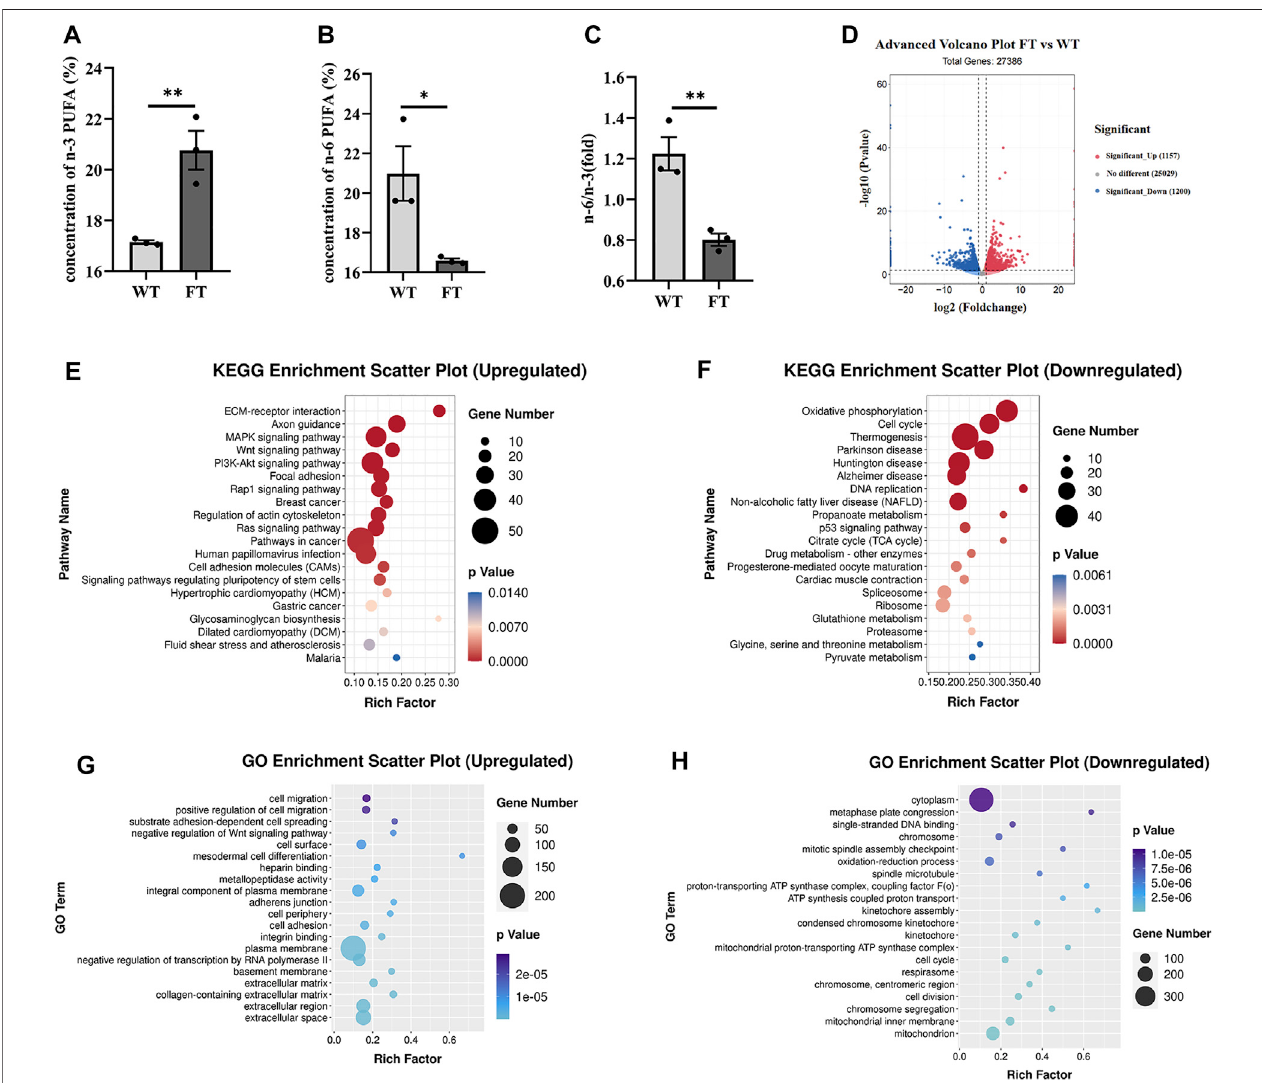
FIGURE 1 | Exogenous fat-1 gene affects ATP synthesis in bovine fetal fi broblasts (bEFs). (A,B) Percent total of n-3 PUFA and percent total of n-6 PUFA by Gas Chromatography-Mass Spectrometer (GC-MC). N-3 PUFA (sumofC18:3n3,C20:3n3,C20:5n3C22:6n3 andC18:2n6t),N-6 PUFA(sumofC18:2n6c,C18:3n6, C20: 3n6 and C20:4n6). ( n = 3) (C) The ratio of n-6 PUFA to n-3 PUFA was statistically lower in FT. ( n = 3) (D) Differential expression genes between fat-1 and control fi broblasts. Signi fi cant_Up: signi fi cantly upregulated genes; No differernt: no signi fi cant differences in gene expression; Signi fi cant_down: signi fi cantly downregulated genes. ( n = 3) (E) KEGG pathway upregulating enrichment. (F) KEGG pathway downregulating enrichment. (G) GO upregulated enrichment analysis of differential genes. (H) GO upregulated enrichment analysis of differential genes. Each dot represents an independent experiment, 0001 Each dot represents an independent experiment (A – C) . All data are presented as mean ± SEM. Compared with the WT group, * p < 0.05, ** p < 0.01, *** p < 0.001, **** p < 0.0001; t-tests were used to calculate the p